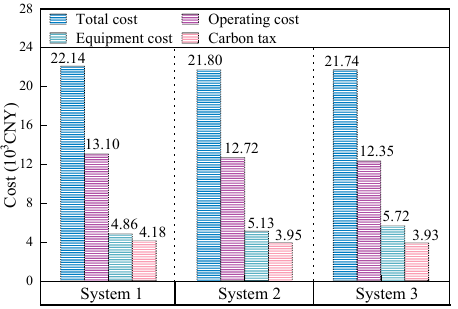
Figure 5. Cost differences between the three systems.